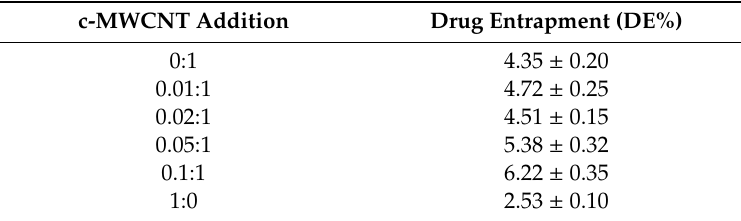
Table 2. Drug entrapment (DE%) of drug-loaded MPEG-PDLLA / c-MWCNT nanocomposites prepared from the MPEG-PDLLA / c-MWCNTs mixed solutions with di ff erent c-MWCNT (tube diameter < 8 nm, length 0.5~2 µ m)